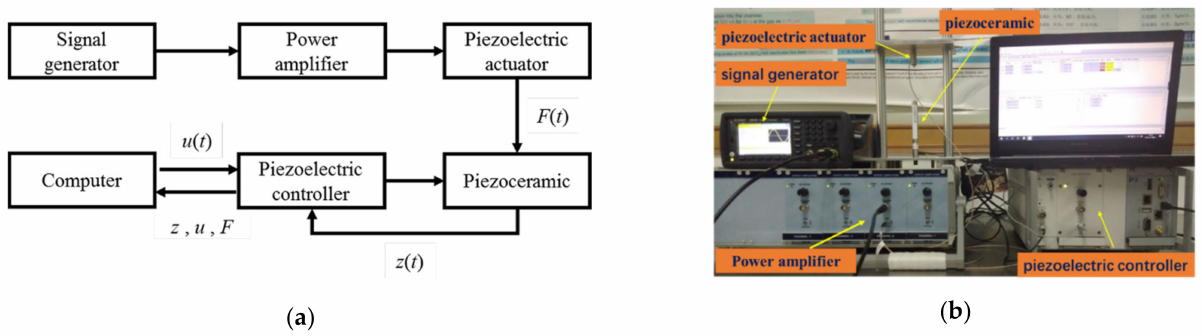
Figure 1. ( a ) Flow chart of piezoceramic performance, ( b ) experimental